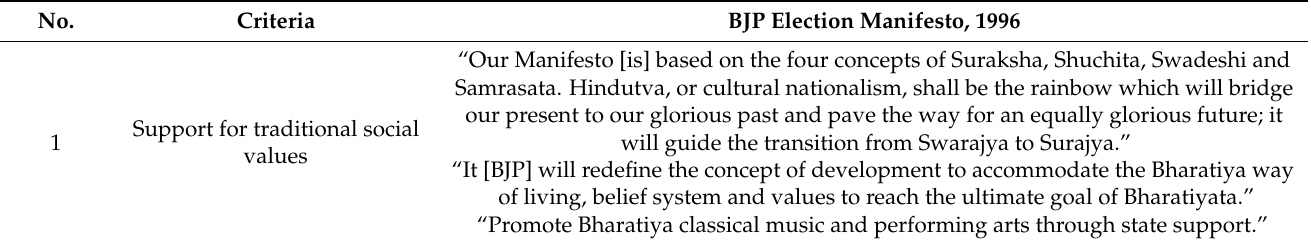
Table 5. Hindu nationalism and populism in Bharatiya Janata Party based on 1996 manifesto (BJP